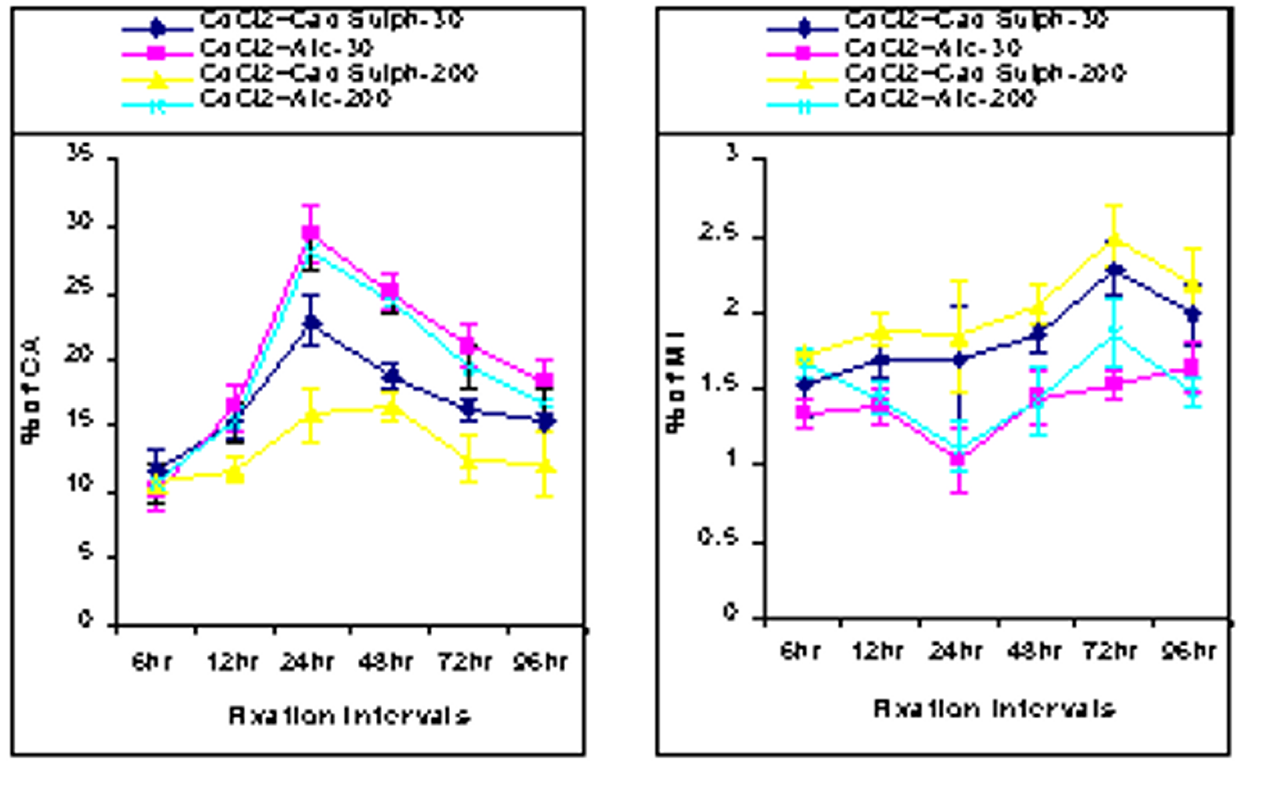
Figure 2 Showing time-dependent frequencies of Cad Sulph-30 pre- fed and Cad Sulph-200 pre-fed series versus their respective CdCl 2 treated alcohol-30 and alcohol-200 control mice.